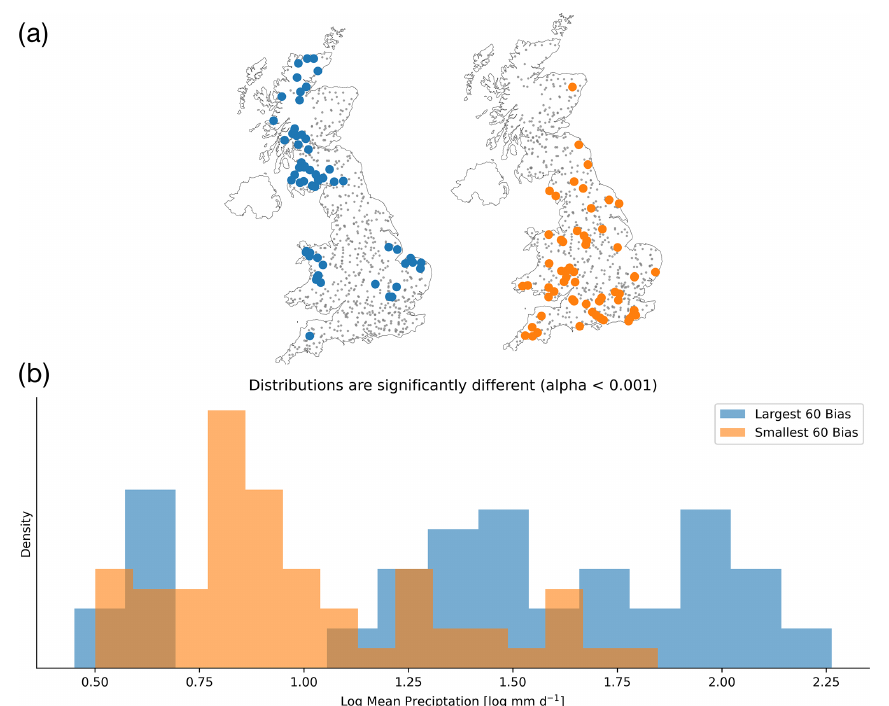
Figure 4. (a) The spatial location of the 60 catchments with the largest probe biases (blue) and smallest probe biases (orange). (b) The distribution of catchment log mean precipitation for the catchments with the largest and smallest probe biases. The largest 60 biases (blue) occur in catchments that are wetter or drier than average, as demonstrated by the gap in the middle of the distribution of mean catchment precipitations. By contrast, the smallest 60 biases (orange) are mostly concentrated in the middle of the distribution, as we expect when using a simple linear model as the probe. These distributions are significantly different when using a two-sample Kolmogorov–Smirnov